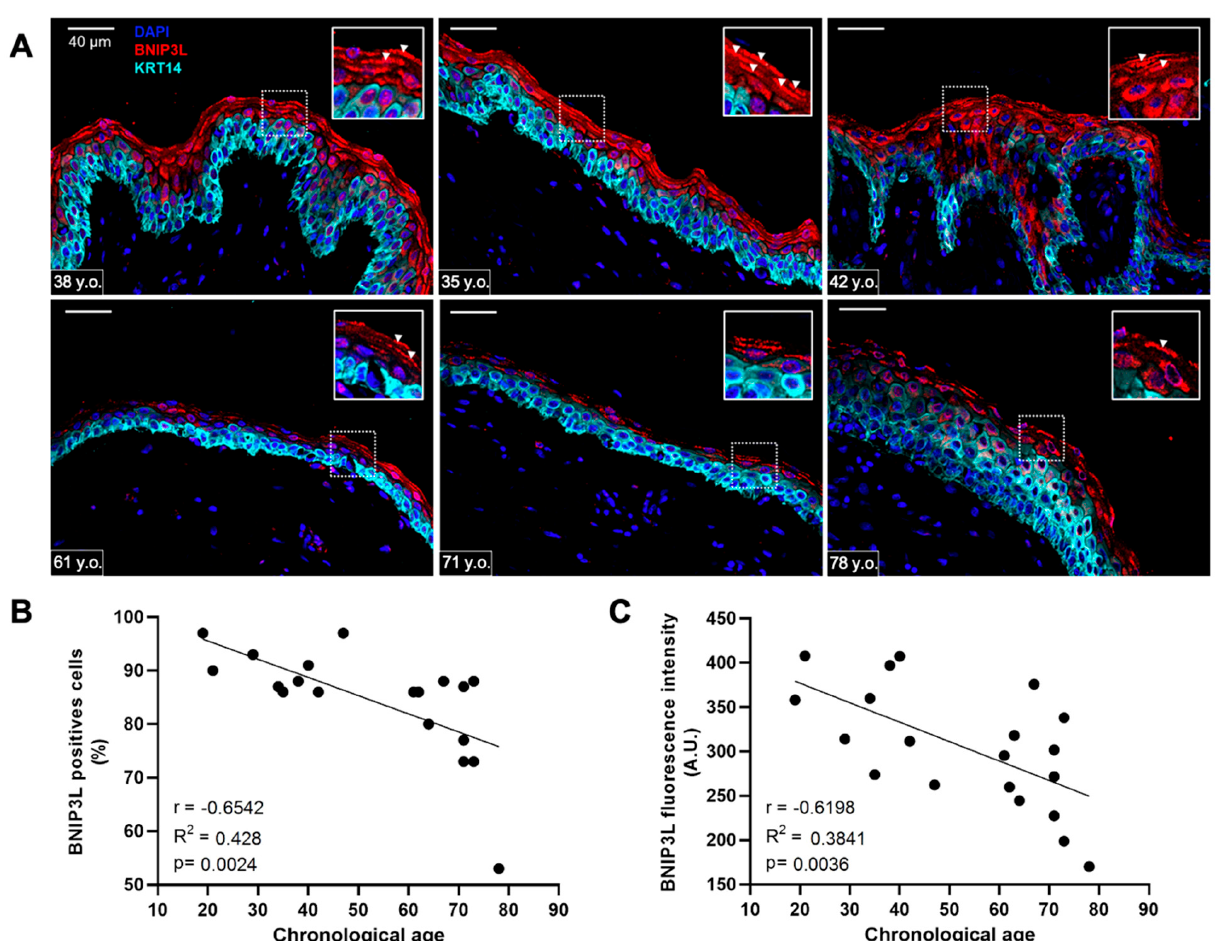
Figure 3. BNIP3L expression in human skin biopsies from individuals at different ages. ( A ) Immunofluorescent staining of BNIP3L and KRT14 in human skin sections. Representative photographs of 6 individuals from two different age groups: adult, or aged people (top, from left to right: 38, 35 and 42 years old; bottom, from left to right: 61, 71 and 78 years old). Inserts are a magnification of the selected area showing BNIP3L-positive cells (white arrowheads) ( B ) Mathematical correlation between the percentage of BNIP3L-positive cells from the whole epidermis and the chronological age of the individual from which the skin biopsy has been sampled ( n = 21). Exact p -value was determined using the Pearson correlation test. ( C ) Mathematical correlation between the total BNIP3L fluorescence intensity from the whole epidermis and the chronological age of the individual from which the skin biopsy has been sampled ( n = 21). Exact p -value was determined using the Pearson correlation test.